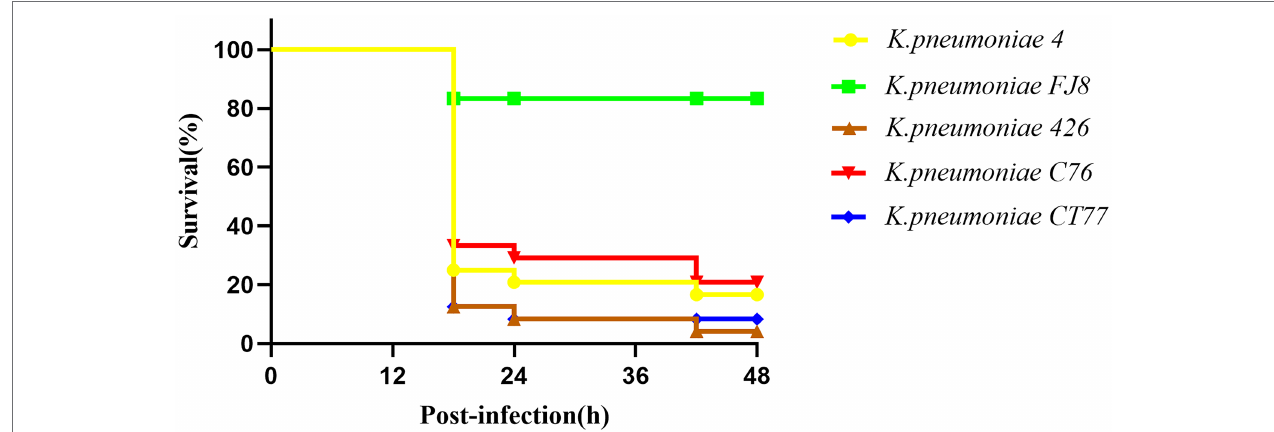
FIGURE 2 | Virulence of K. pneumoniae isolates in the G. mellonella infection